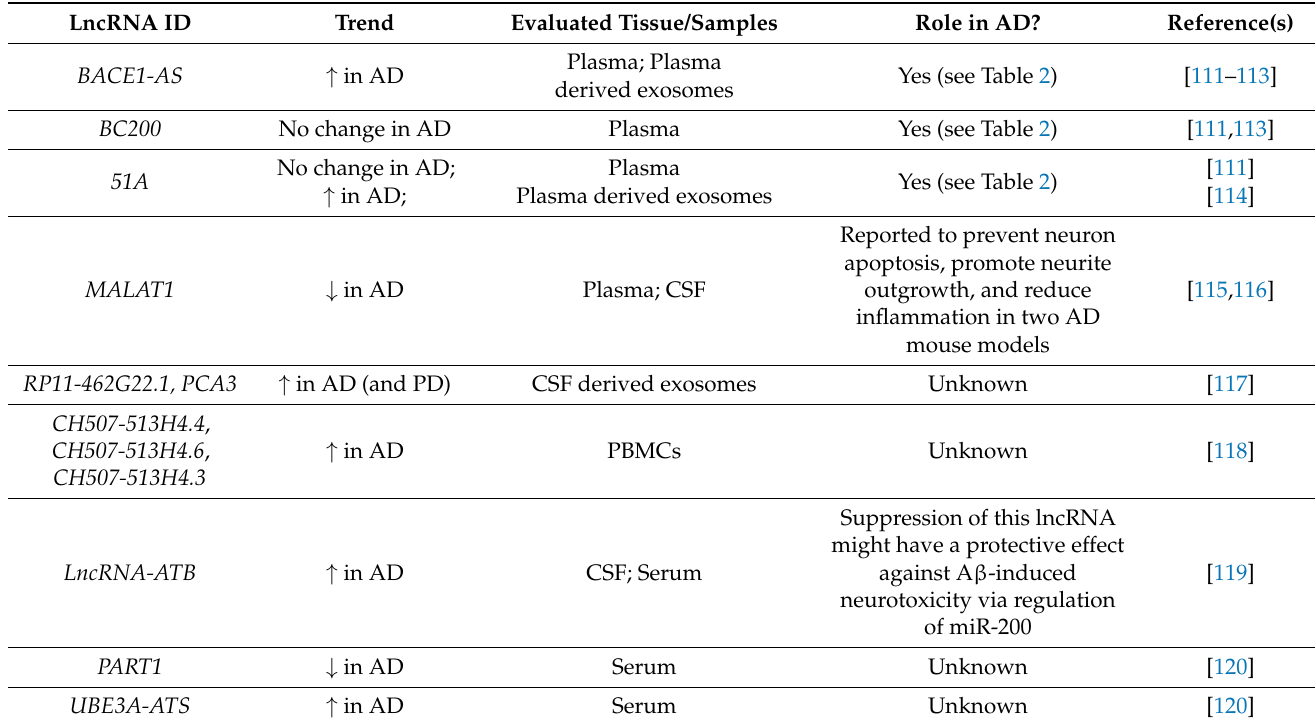
Table 3. Examples of deregulated lncRNAs in peripheral tissue samples from patients with